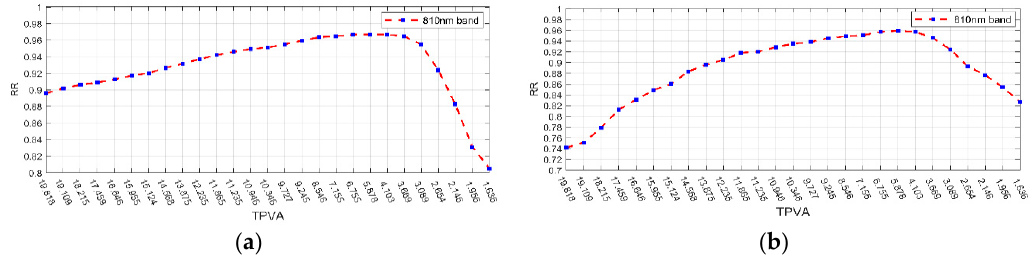
Figure 9. Recognition rates (RR) with different acutance (corresponding to δ ) for every band (spectrum) of HDHV using different local texture patterns. Results using the feature extraction methods of ( a ) regional local binary patterns (LBP); ( b ) deep features. Figure 10. Recognition rates (RR) with different acutance TPVA on a single band of HDHV with different local texture patterns. Results using the feature extraction methods of ( a ) regional LBP; ( b ) deep features.